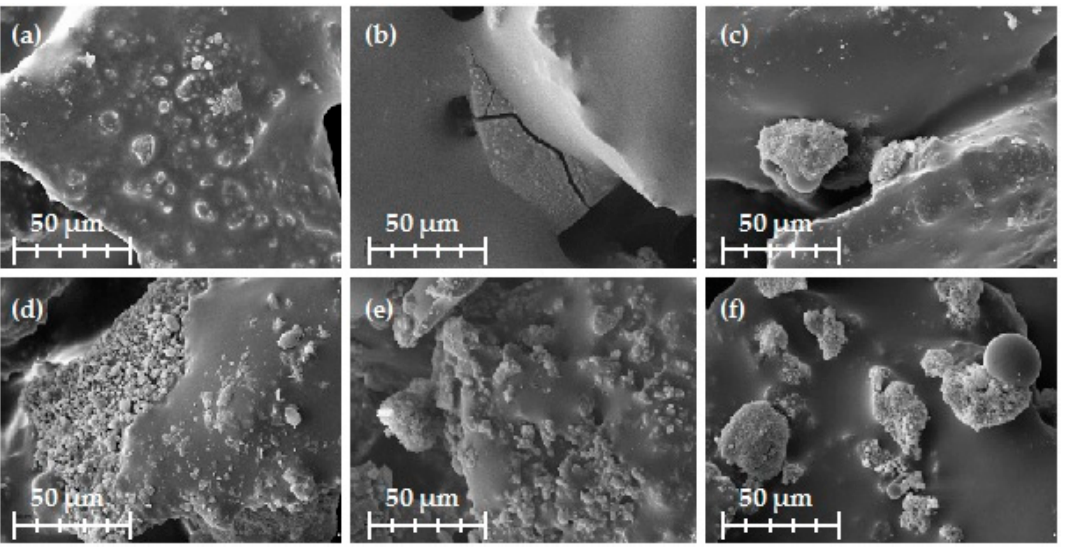
Figure 11. Scanning electron microscopy images of examined composites: ( a ) MLS; ( b ) MLS activated using NaIO 4 ; ( c ) MLS activated using H 2 O 2 ; ( d ) KL; ( e ) KL activated using NaIO 4 ; and ( f ) KL activated using H 2 O 2 .